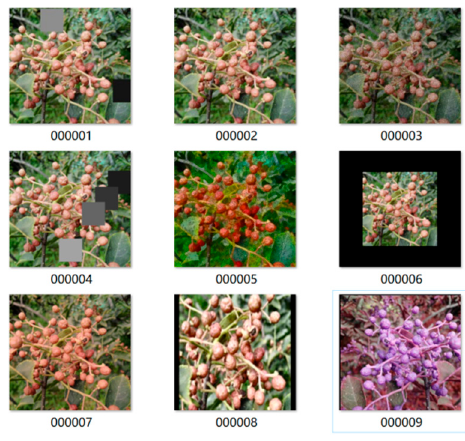
Figure 3. Data enhancement sample.